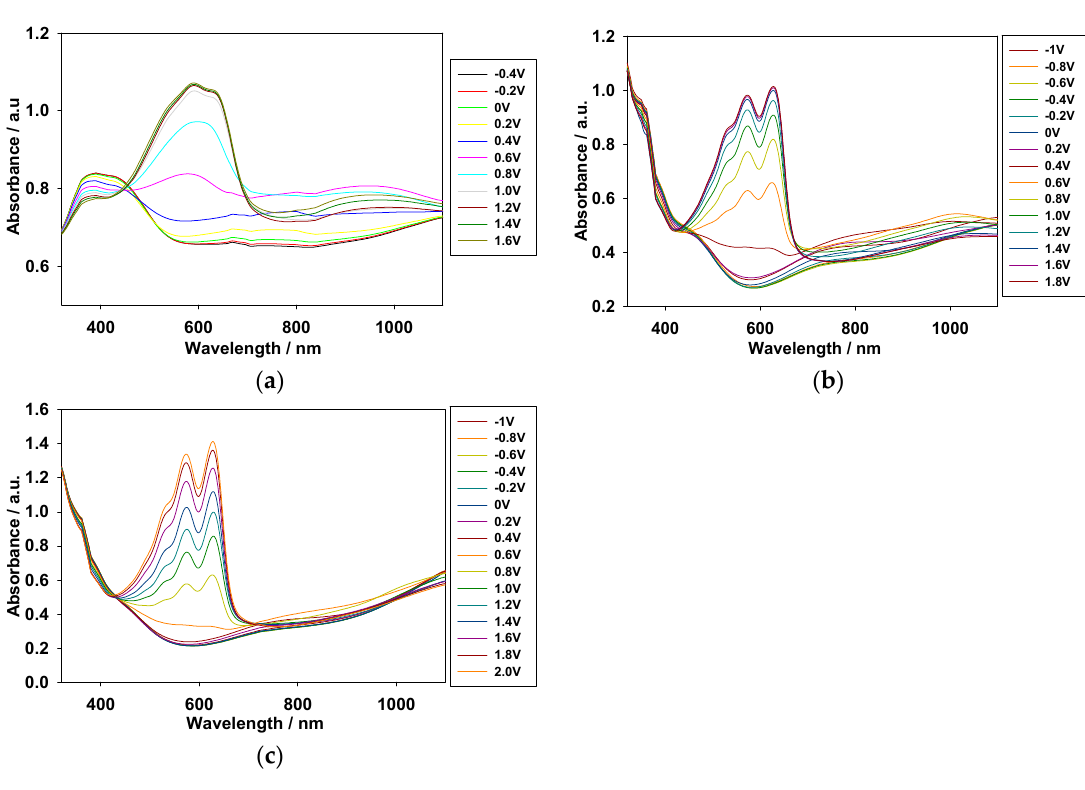
Figure 7. Spectroelectrochemical spectra of ( a ) PMPS/PProDOT-Et 2 ; ( b ) PMPO/PProDOT-Et 2 ; and ( c ) PANIL/PProDOT-Et 2 ECDs at various potentials.